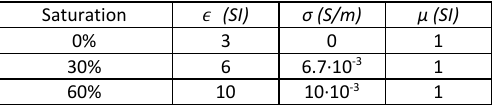
Table 2. Electromagnetic properties of the simulated samples.